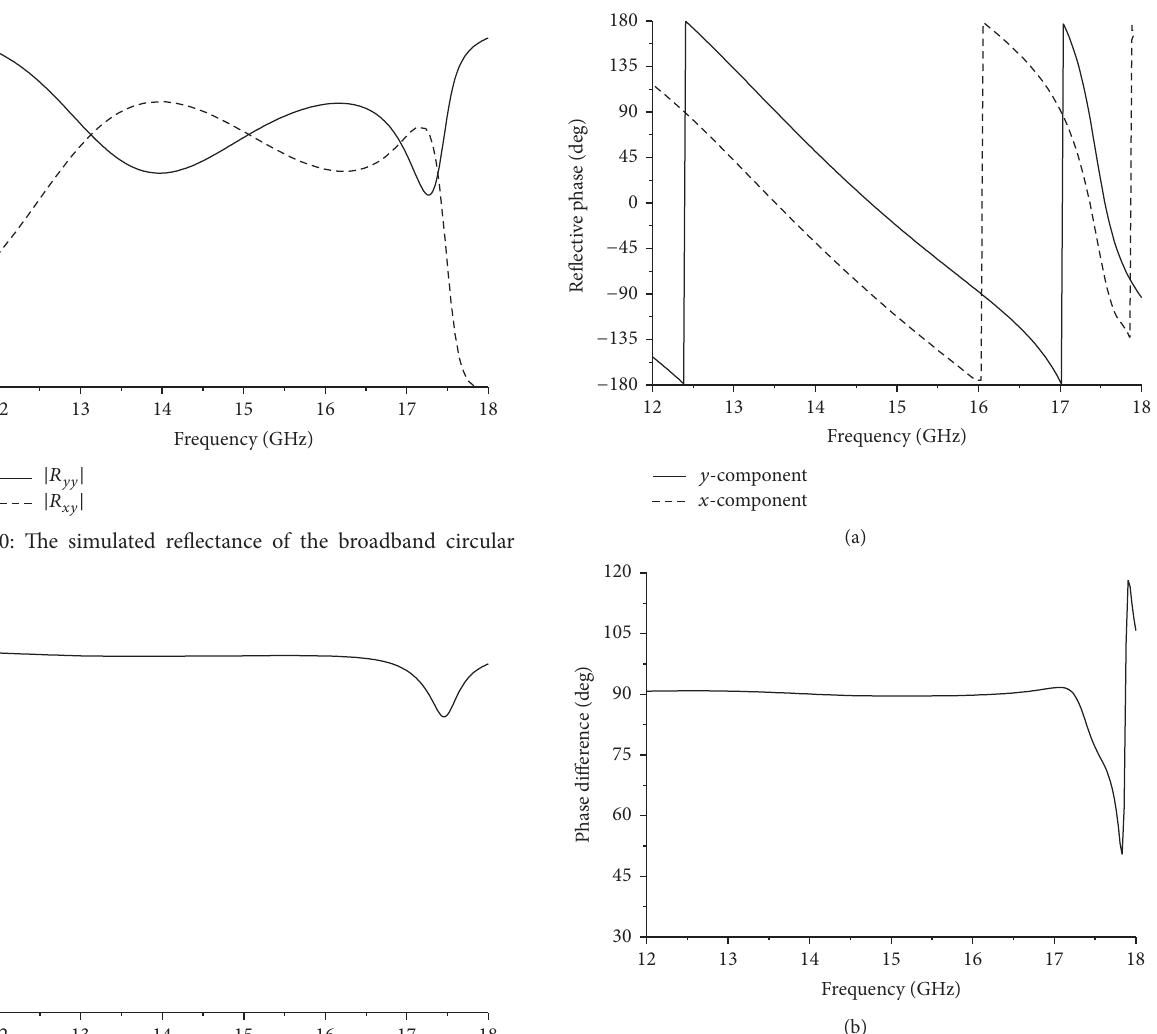
total reflection amplitude calculated by √𝑅 2 𝑦𝑦 + 𝑅 2 𝑥𝑦 . From 12.66 GHz to 17.43 GHz, the total reflection amplitude is above 0.8.